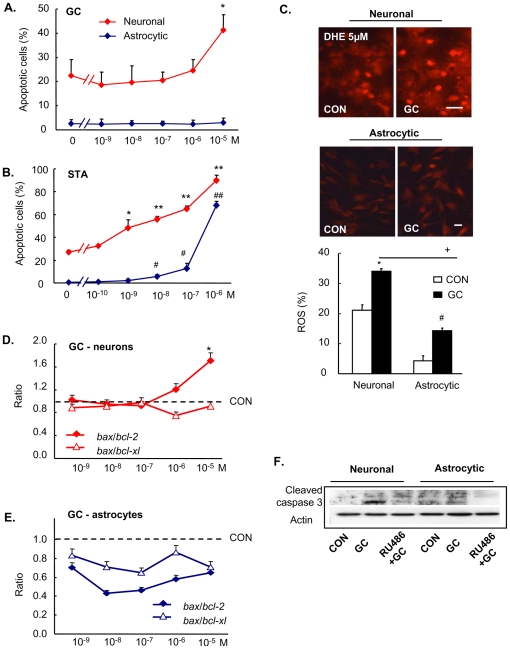
Insights into potential mechanisms underlying astrocytic resistance to GC-induced apoptosis.Astrocytes show less susceptibility to GC- (A) and staurosporine (STA)-induced (B) apoptosis, as compared to neuronal cells. Both neurons and astrocytes respond to GC treatment with a significant increase of ROS (measured by fluorescent DHE nuclear translocation) (C); note that, as compared to neurons, astrocytes generate markedly lower levels of ROS under basal conditions and after GC treatment. The ratios of expression of mRNAs for pro- vs. anti-apoptotic members of the Bcl2 family (bax vs. bcl-XL and bcl-2) are different in neurons and astrocytes (D and E); mRNA levels were determined by qPCR. Neurons and astrocytes also respond differentially to GC treatment in terms of their activated caspase 3 responses (measured by immunoblotting) (F), with astrocytes showing smaller increases in levels of activated caspase 3. Numerical data are shown as mean ± SD. * p<0.05 vs. neuron CON; # p<0.05 vs. astrocyte CON; + p<0.05 GC-treated neurons vs. GC-treated astrocytes. Scale bars: 25 µm.